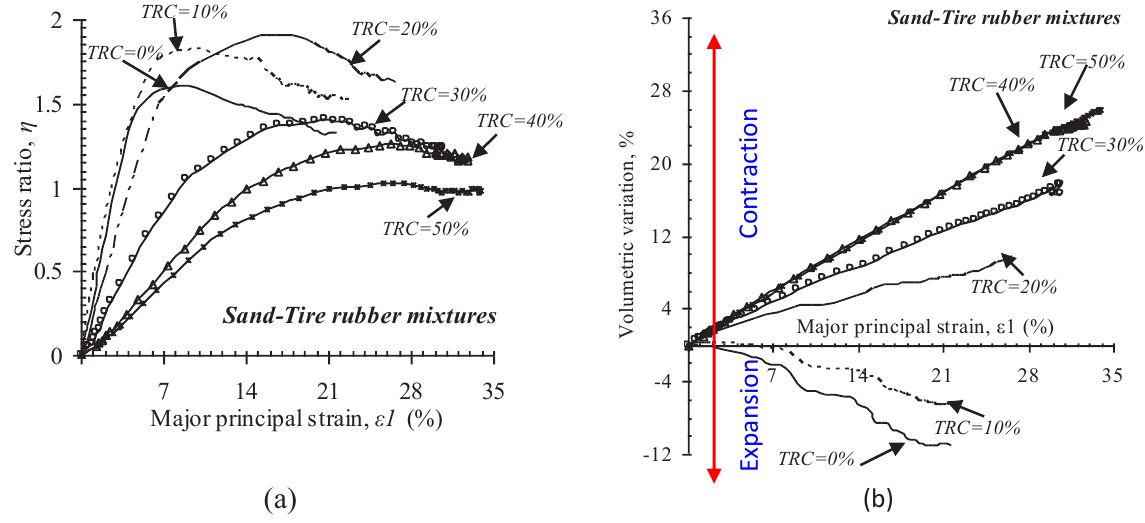
Figure 2: Relationship between (a) stress ratio and major principal strain and (b) volumetric variation and major principal strain of specimens based on different contents of tire